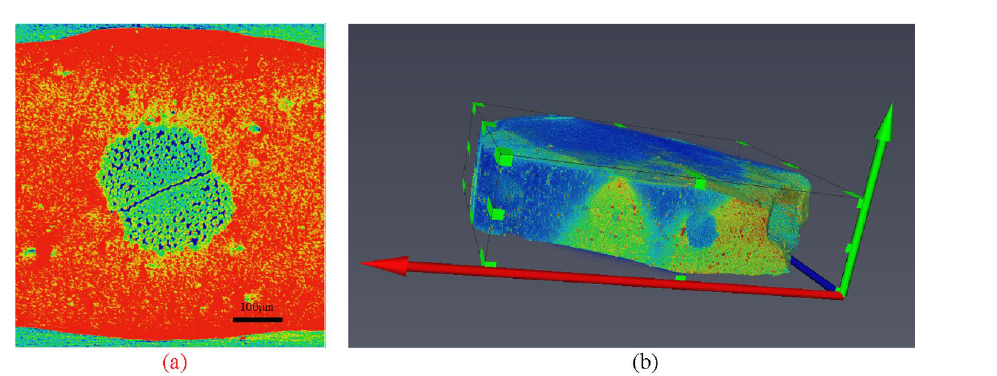
Figure 13. CT image of uncured nylon-rubber composite.